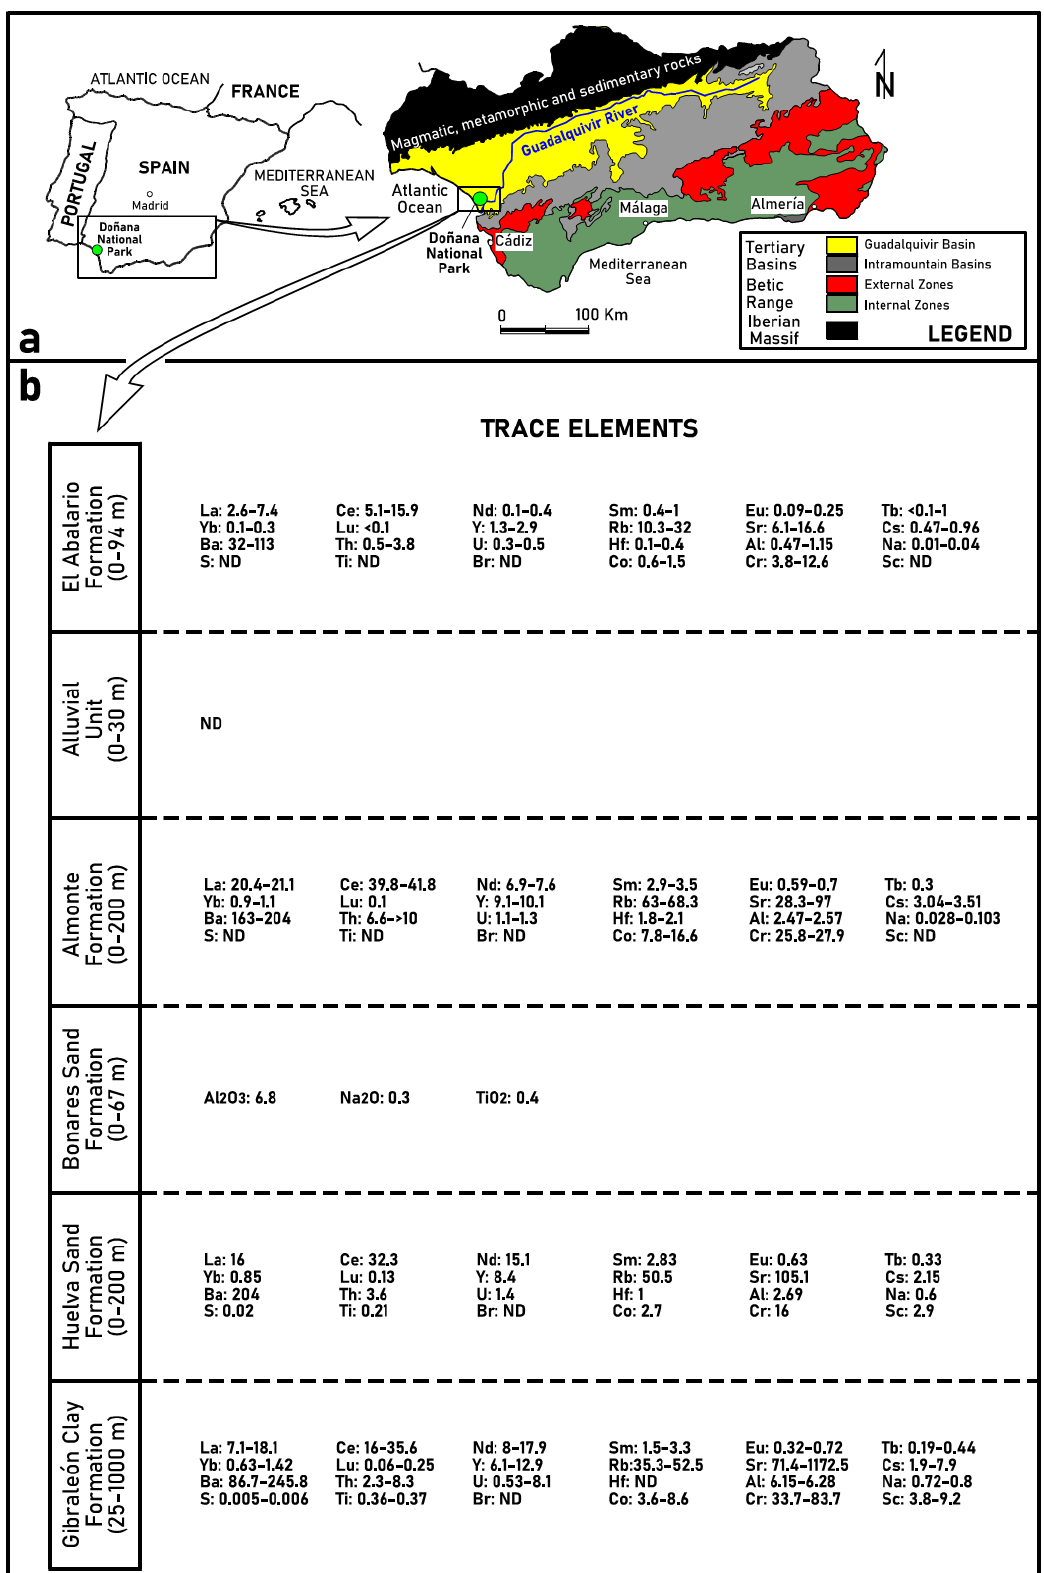
Figure 1. ( a ) Synthetic geology of southern Spain; ( b ) SW Guadalquivir Basin: geochemistry of the main geological formations. ND: no data .